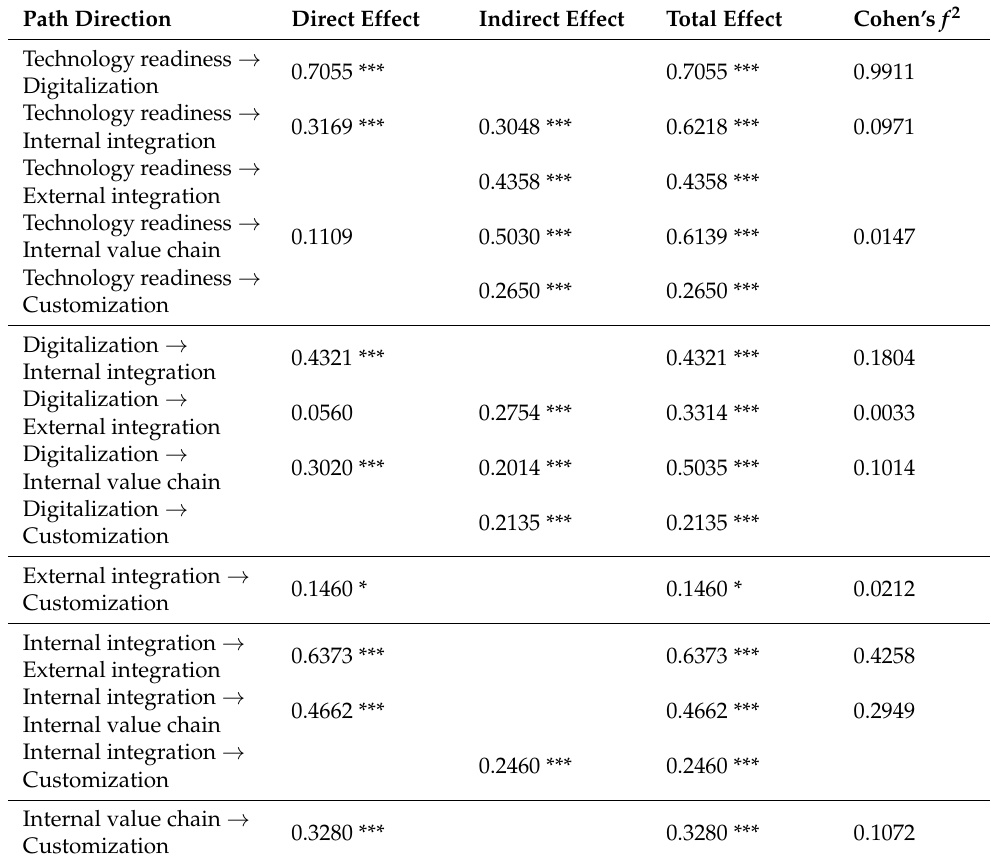
Table 5. The structural model effects